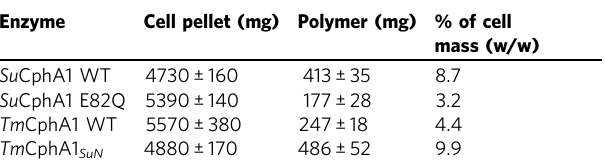
Table 1 Heterologous cyanophycin production in E. coli